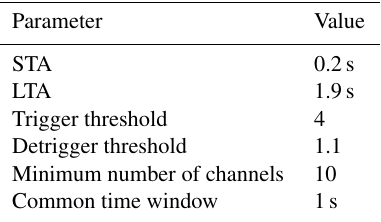
Table A1. STA/LTA parameters used for event